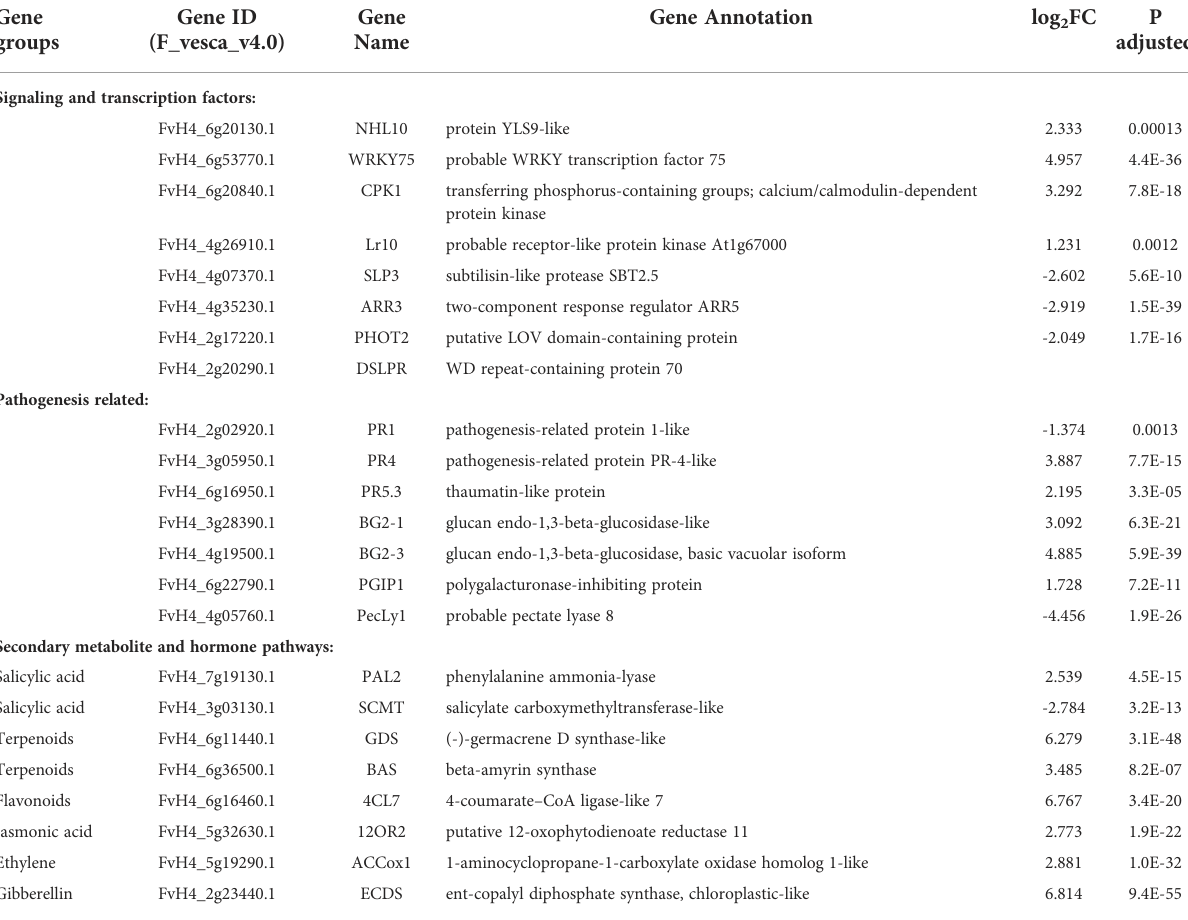
TABLE 1 Differentially expressed genes selected for qRT-PCR expression analysis from Fragaria vesca leaves infected with Botrytis cinerea . Gene